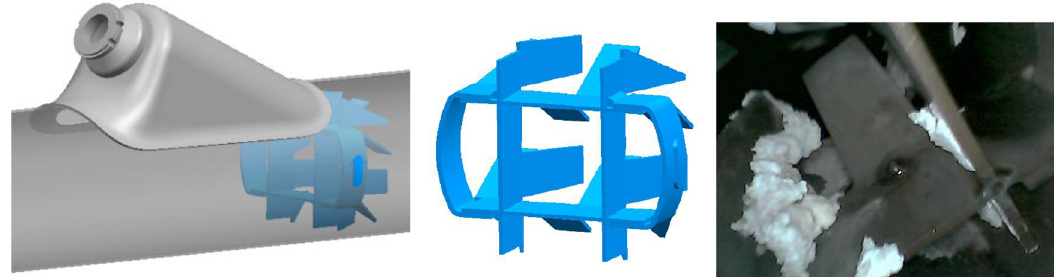
Fig. 1. Traditional SCR mixer structure.